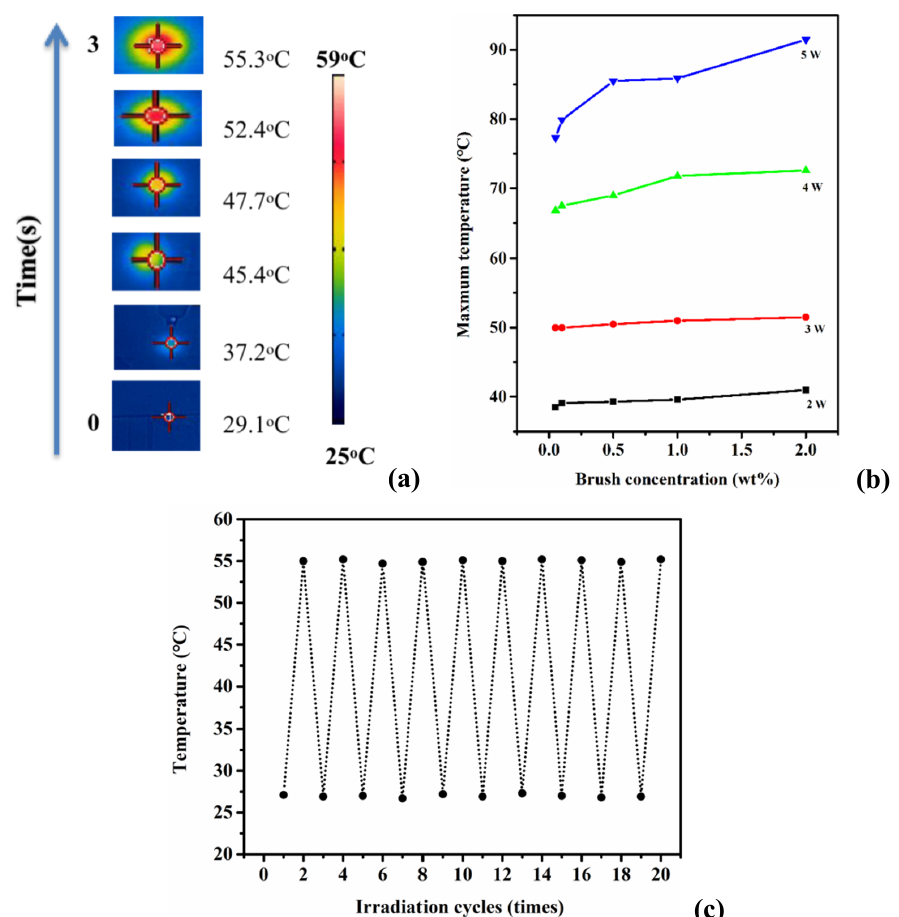
Figure 6. ( a ) IR images of the substrate coated with CNT-PDB polymer brush recorded at different NIR light irradiation times. ( b ) The maximum heating curves of polymer brushes with different concentrations under different NIR irradiation intensities. ( c ) The temperature of CNT-PDB polymer brush under cyclic NIR light radiation.